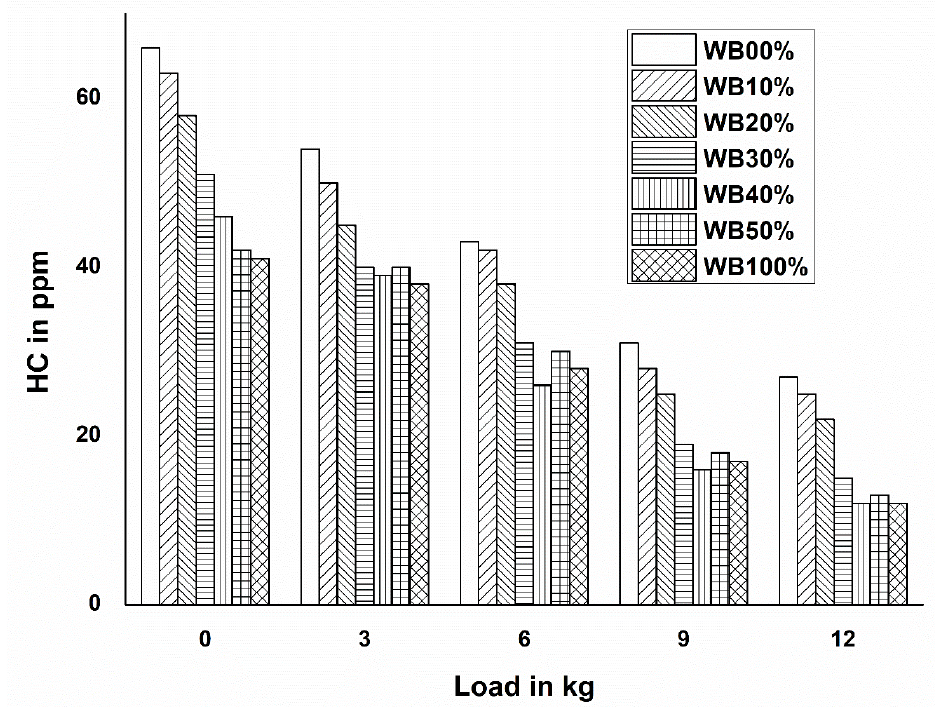
Figure 10. HC emissions ’ variation against load for biodiesel and the blends (kg).